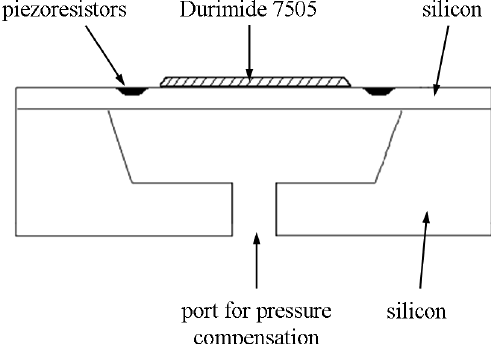
Figure 4. Schematic cross section of the sensor chip with a Durim- ide layer (not to scale). For pressure compensation, a port was etched onto the bottom of the chip.